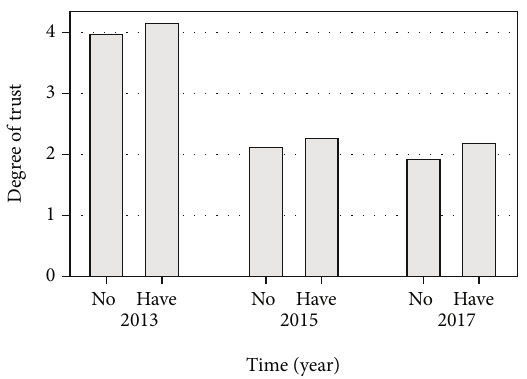
Figure 1: Smartphone usage and changes in residents ’ trust. ∗ Data source: data from the China Household Finance Survey